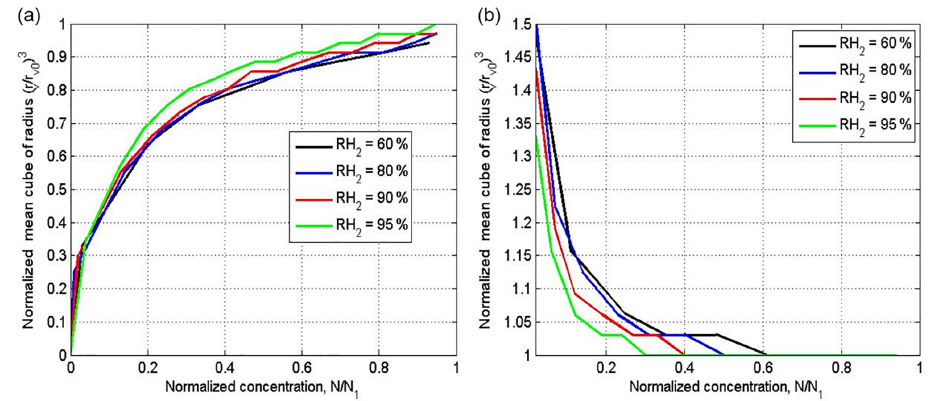
Figure 11. Dependencies of the normalized cube of the mean volume radius on normalized droplet concentration for different initial relative humidity values. (a) Narrow initial DSD. (b) Wide initial DSD. The initial mixing parameters are T = 10 ◦ C, p = 828.8mb and L =